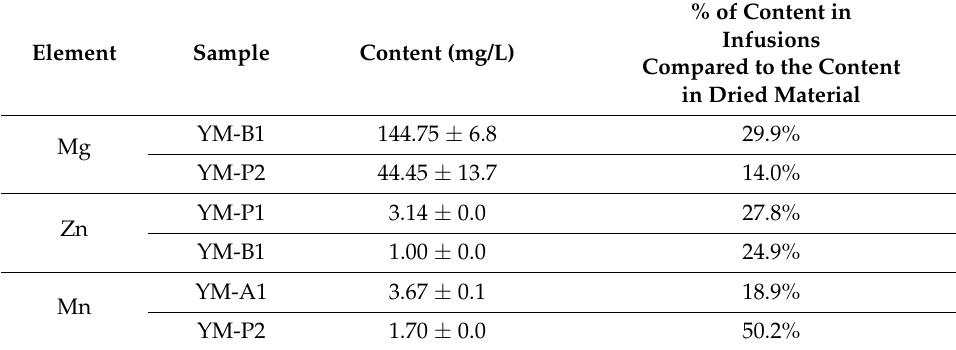
Table 1. Mg(II), Zn(II), and Mn(II) contents of yerba mate infusions.